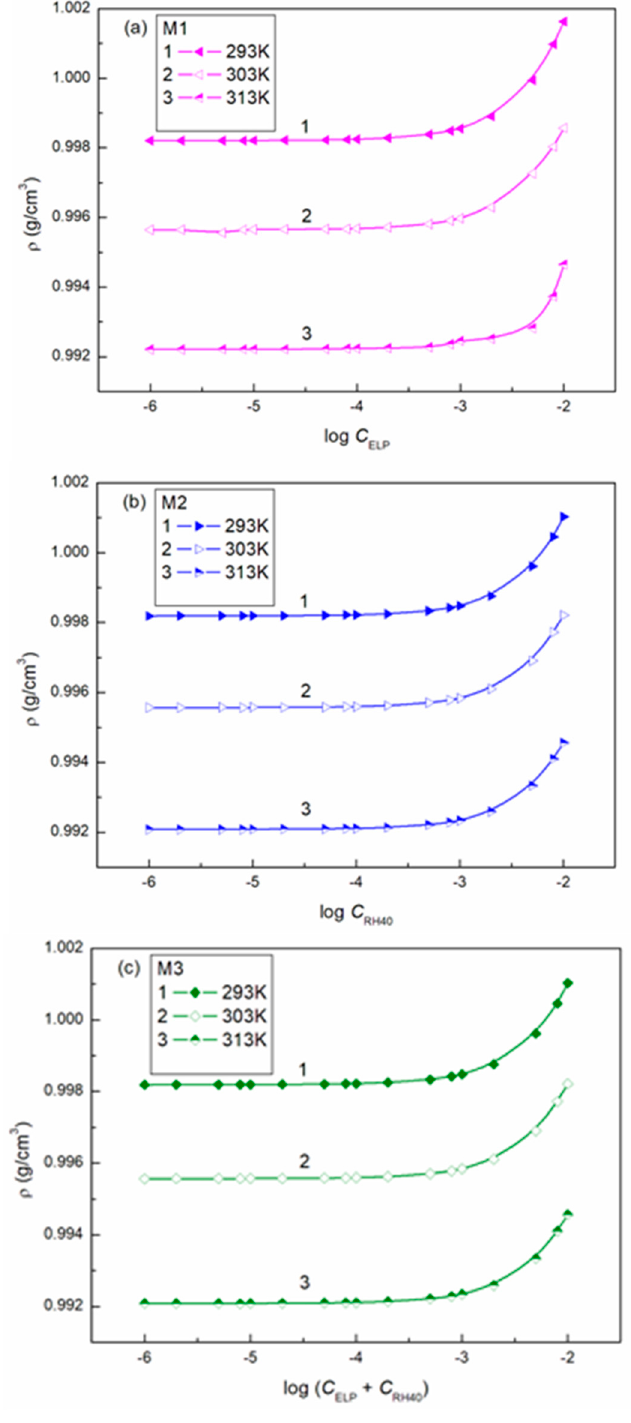
Figure 6. A plot of the density ( 𝜌 ) of mixtures M1 ( a ), M2 ( b ) and M3 ( c ) vs. the logarithm of the surfactant or their mixture concentration at a constant temperature equal to 293 K (curve 1), 303 K (curve 2), and 313 K (curve 3).